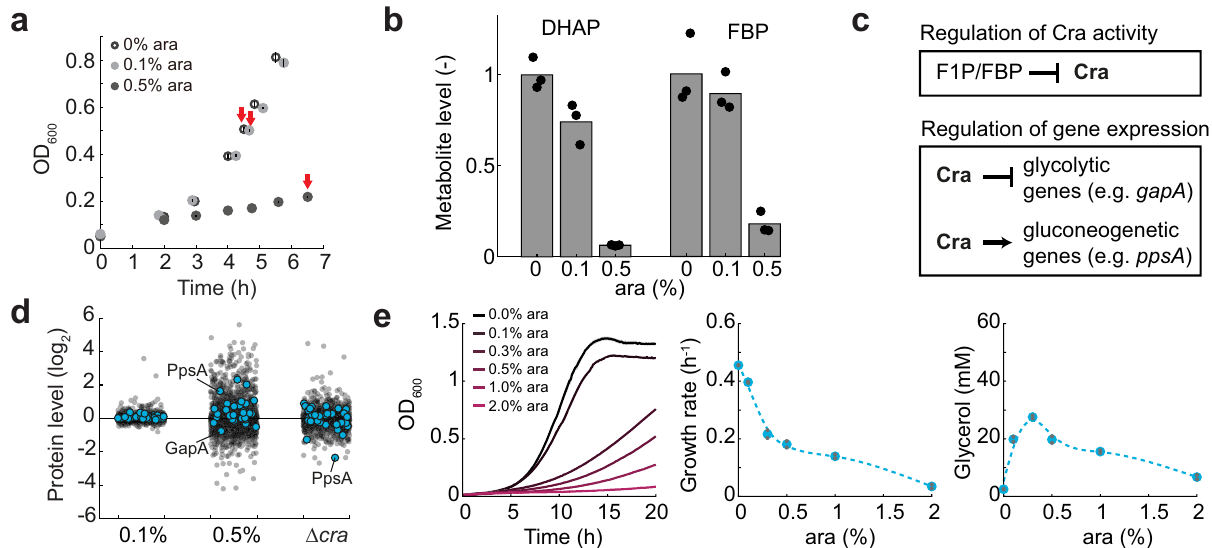
Fig. 2 Induction of the glycerol pathway activates the transcription factor Cra. a Growth of the base strain ( E. coli Δ glpK with the pBAD glycerol plasmid) at different induction levels (0, 0.1, and 0.5% ara). The base strain was cultured in n = 3 shake fl asks and samples for metabolomics and proteomics were collected at the time points indicated by red arrows. Dots are means and lines are standard deviations of the OD 600 in n = 3 shake fl ask cultures. b Intracellular concentration of dihydroxyacetone phosphate (DHAP) and fructose-1,6-bisphosphate (FBP). Data are normalized to the 0% culture. Dots are data of n = 3 independent shake fl ask cultures and bars are the mean. c Fructose-1-phosphate (F1P) and FBP inhibit the activity of the transcription factor Cra. Cra activates the expression of genes encoding gluconeogenic enzymes (e.g., ppsA ) and represses those of glycolytic enzymes. d Proteome data showing the relative abundance of proteins in the base strain with 0.1% ara and 0.5% ara. Data are normalized to the base strain with 0% ara. Δ cra is the proteome of a cra deletion strain, normalized to the wild-type strain. Dots are means of samples from n = 3 independent shake fl ask cultures ( a ). Shown are only protein levels with a relative standard deviation smaller than 20%. Blue dots are enzymes that belong to glycolysis or gluconeogenesis in the i ML1515 model. e The glycerol pathway was expressed in the Δ cra strain. The Δ cra strain was cultured in 96-well plates. Growth was measured in a plate reader at different induction levels of GPD1 (0, 0.1, 0.3, 0.5, 1, and 2% ara). Glycerol in the medium was measured after 24 h. Growth rates were determined by regression analysis between 5 and 10 h. Growth curves and dots show the means of n = 2 plate reader cultures. Source data are provided in the Source Data fi le. Table 1 Values and units of parameters and